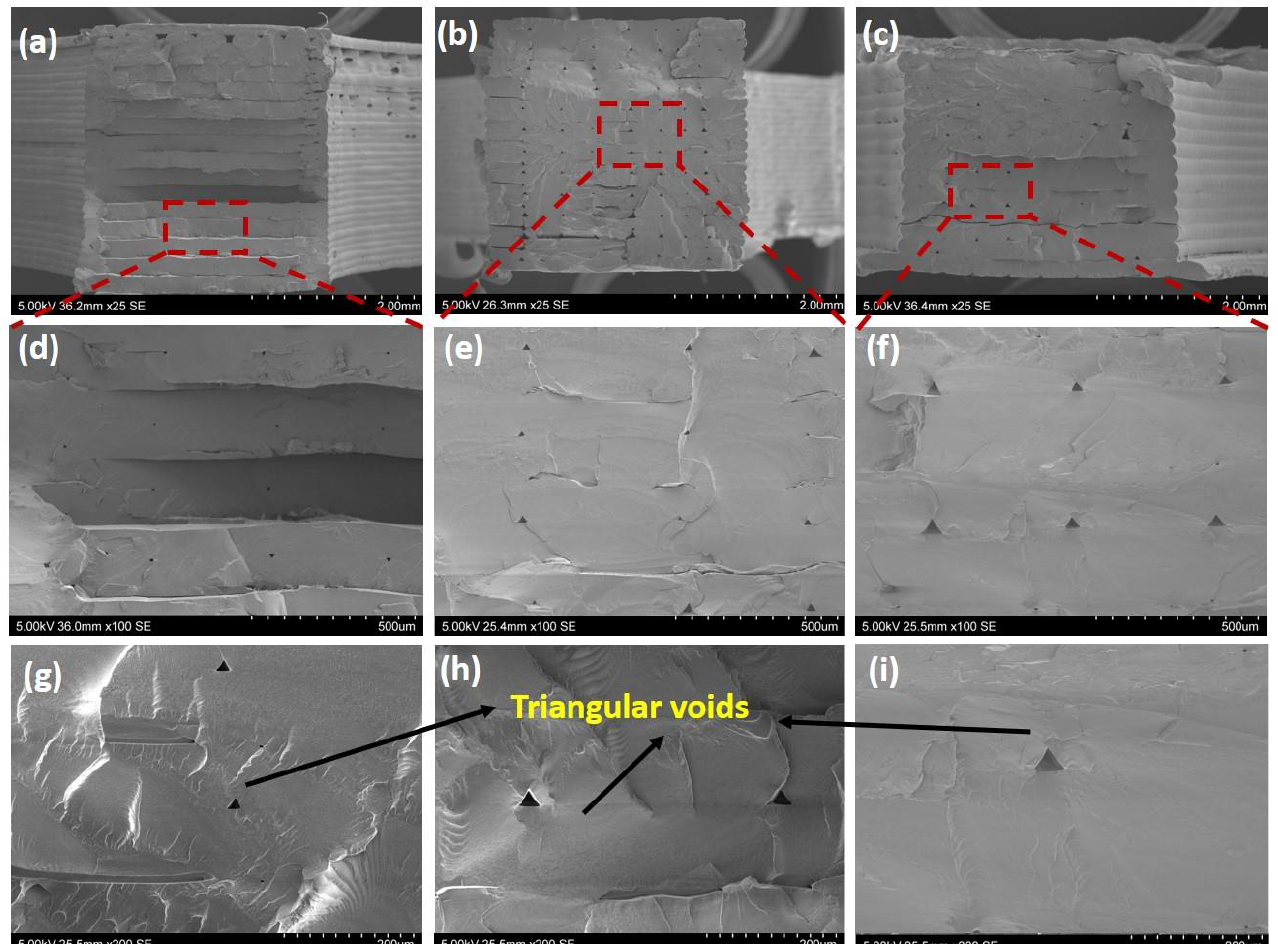
Figure 3. The structure of the printed [0, 90] polyamide samples at different magnifications: 25×: ( a ) polyamide_0.1, ( b ) polyamide_0.125, ( c ) polyamide_0.2; 100×: ( d ) polyamide_0.1, ( e ) polyamide_0.125, ( f ) polyamide_0.2; 200×: ( g ) polyamide_0.1, ( h ) polyamide_0.125, ( i ) polyamide_0.2.